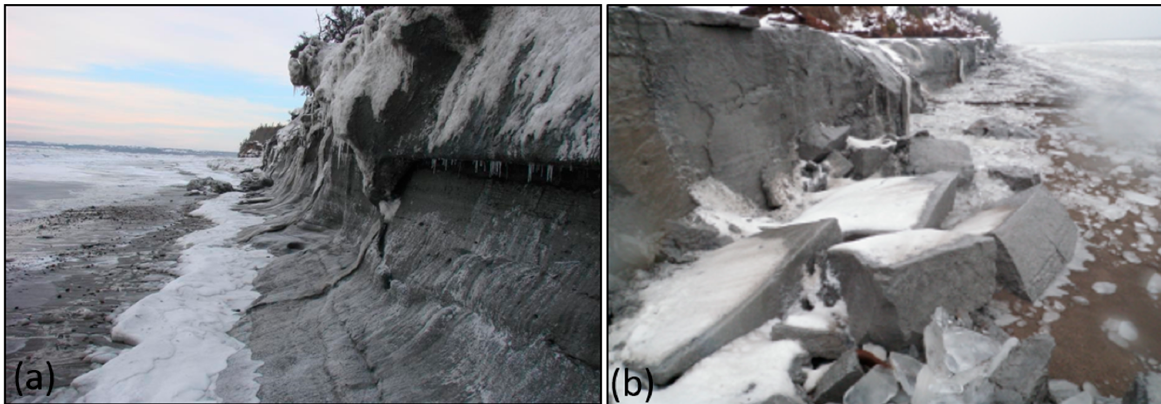
Figure 16. ( a ) Notch formation by thermoabrasion in December; ( b ) block collapse.